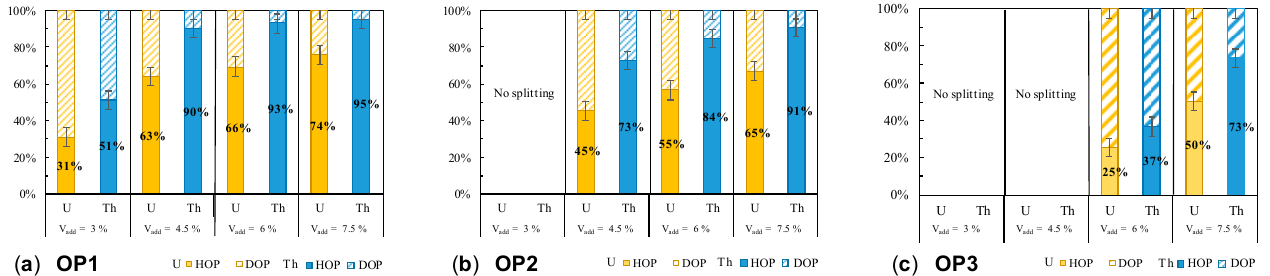
Figure 3. Distribution of U(VI) and Th(IV) in HOP and DOP after splitting of organic phases OP1 3 of low total U + Th concentration (64–68 mM) induced by addition of a controlled volume (Vadd) of concentrated nitric acid solution. Table 2. Detailed composition of heavy organic phases (HOP) arising from the splitting of organic phases OP1-5 induced by the addition of a variable quantity of a concentrated nitric acid solution. Organic Phase